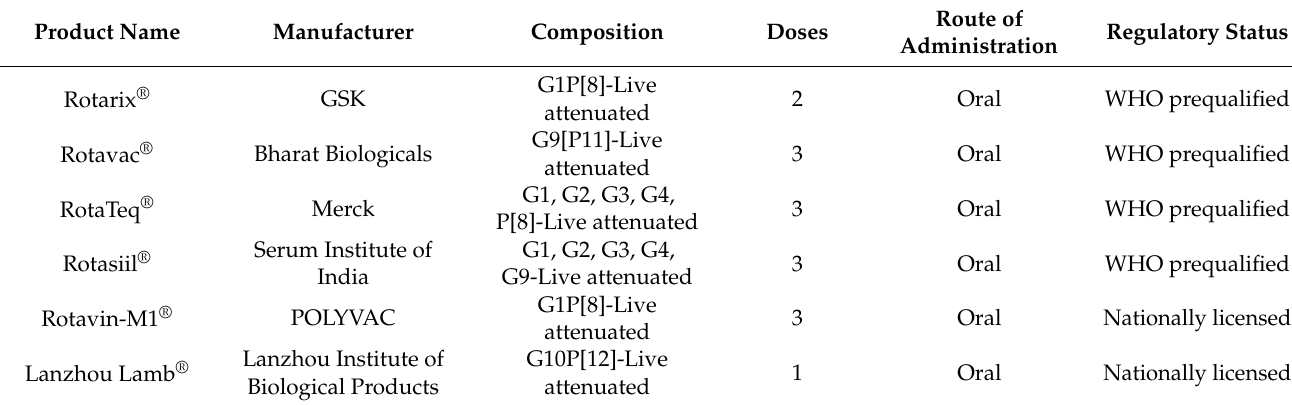
Table 1. Current rotavirus